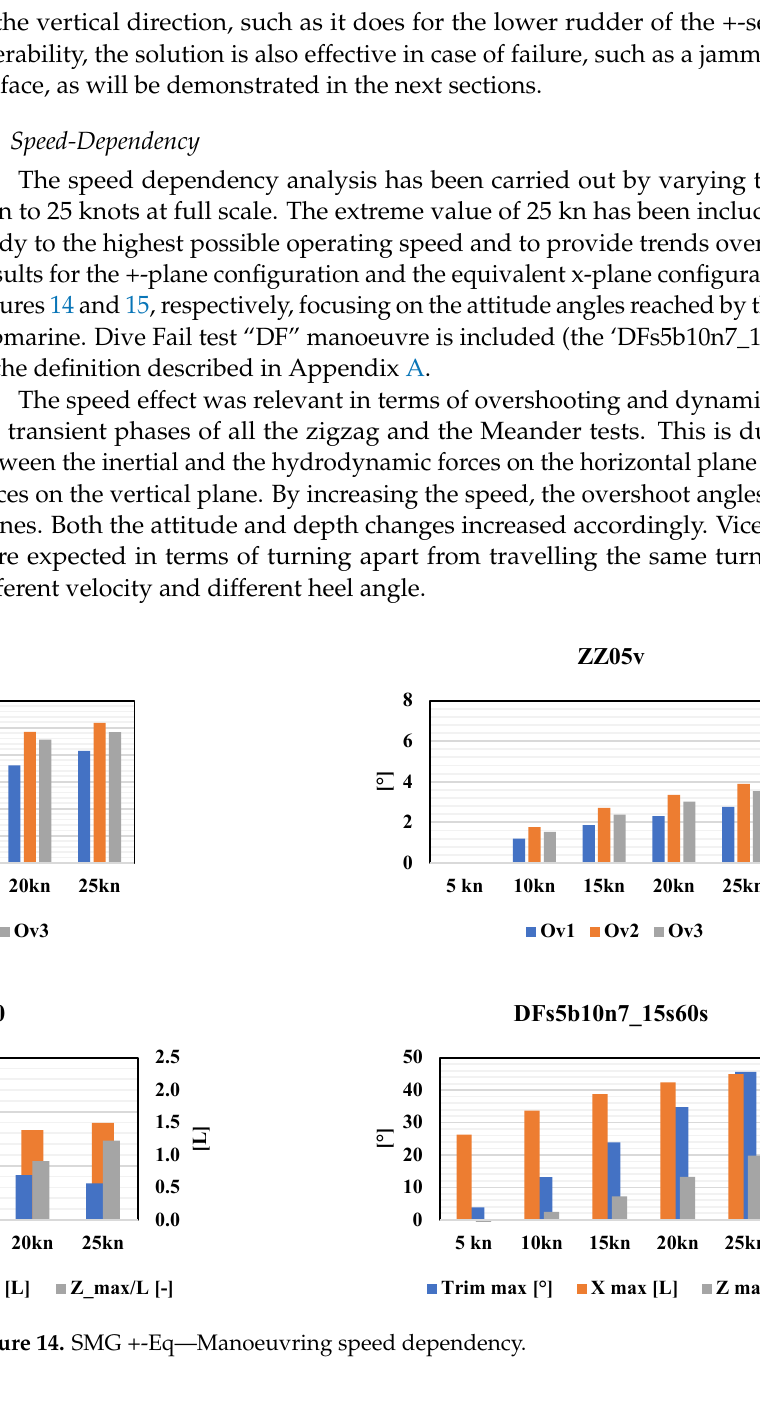
Figure 15. SMG x-Eq—Manoeuvring speed dependency. 4.3. Failure Scenario The failure of the stern steering planes was modelled by considering the surfaces to be jammed in a sequence at defined angles or that they would be lost. According to Figure 16, in the case of horizontal manoeuvre with +-setup, the failed plane was the lower